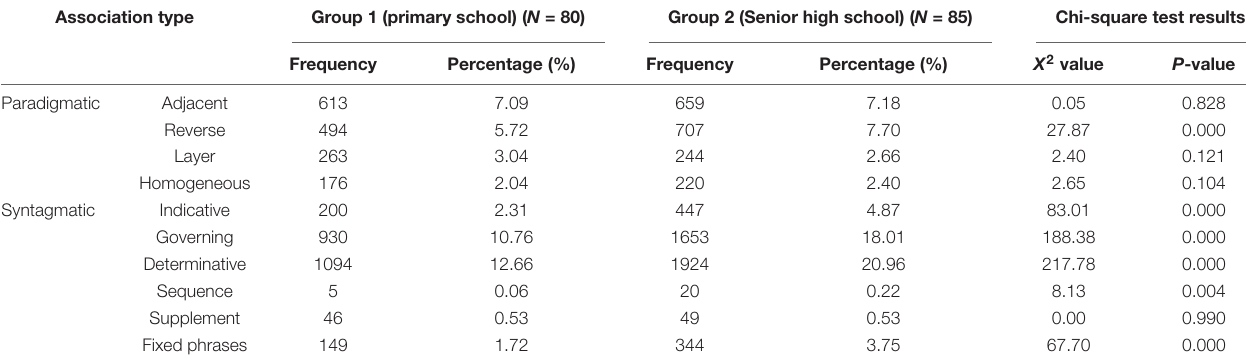
TABLE 5 | The results of word association at the third layer. Association